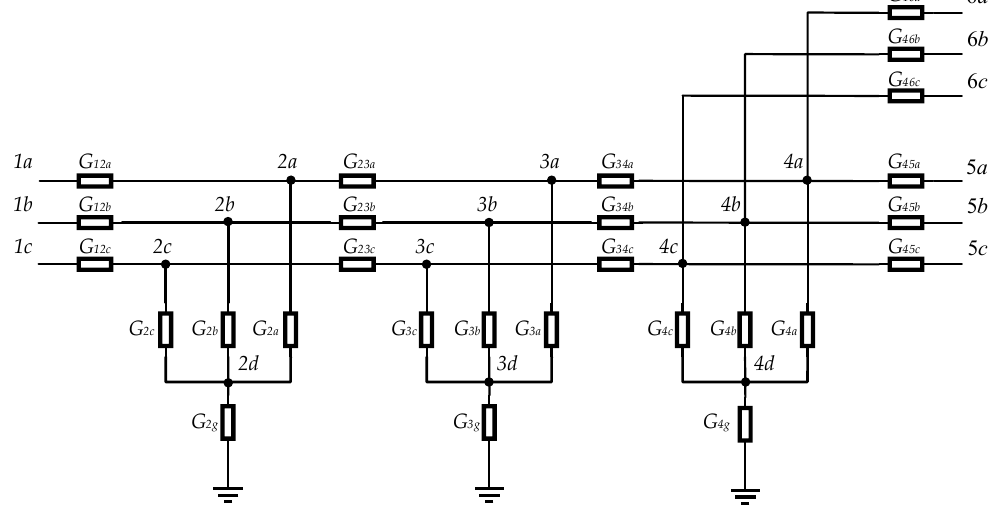
Figure 4. The inlet-outlet line unit connected with the double bus.